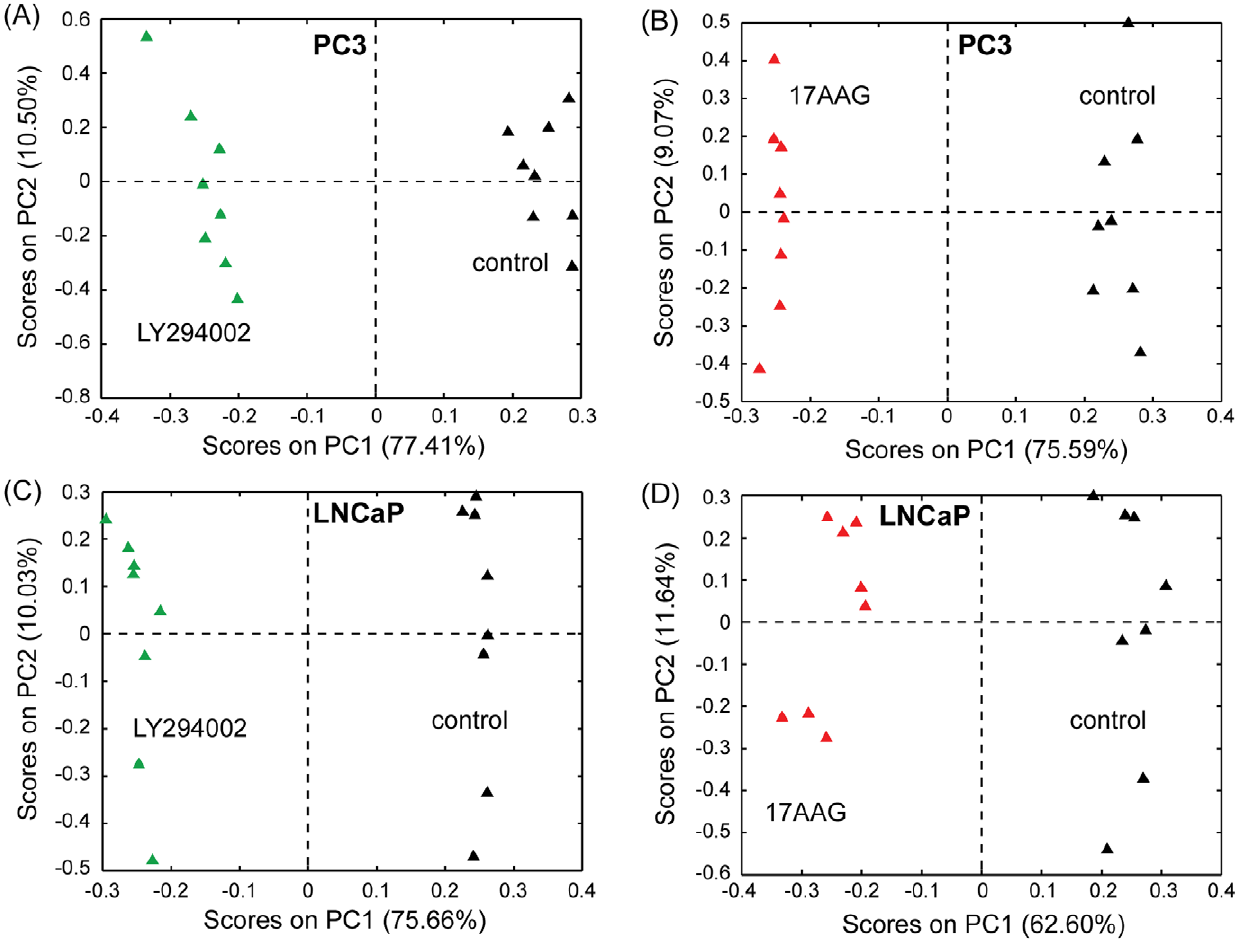
Figure 3. Multivariate statistical analysis of the MR spectra. Scores plots (PC1 vs PC2) obtained by performing PCA on the MR spectra acquired on polar extracts (8 replicates per treatment condition) of PC3 and LNCaP prostate cancer cells. Control samples were compared to samples treated for 48 hours with either LY294002 ((A) for PC3 and (C) for LNCaP cells) or 17AAG ((B) for PC3 and (D) for LNCaP cells).